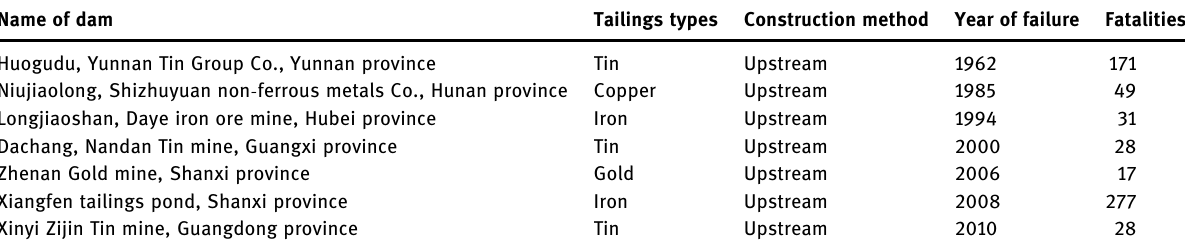
Table 1: Major failures of tailings dams in China Name of dam Tailings types